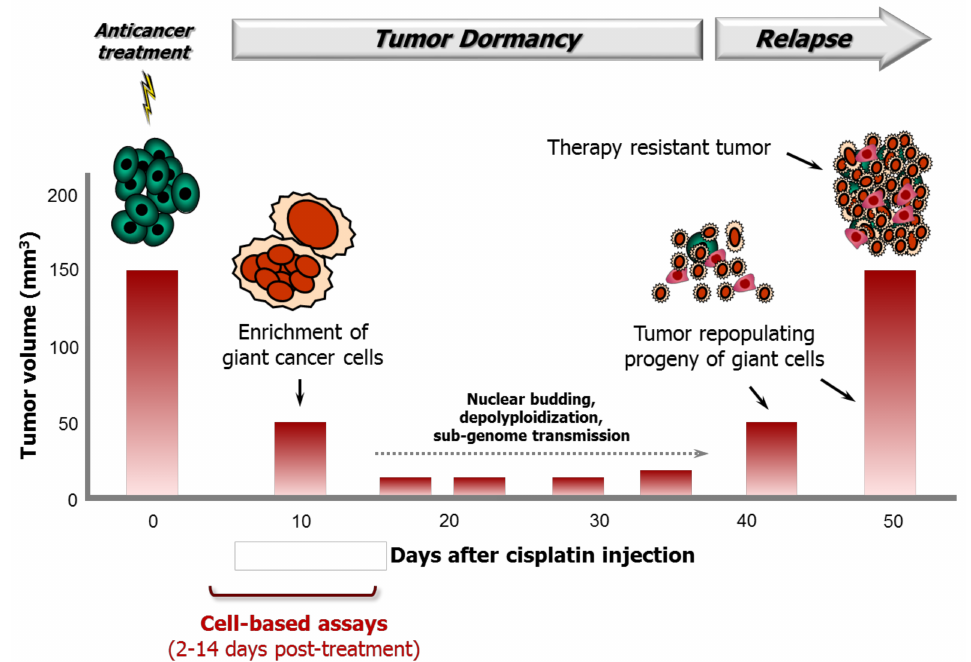
Figure 7. Cartoon illustrating the role of giant cancer cells in tumor response to cisplatin treatment in a syngeneic rat colon carcinoma model reported by Puig et al. [7]. Although cisplatin treatment results in initial tumor shrinkage and a dormant state up to ~35 days post-treatment, it also triggers the creation of polyploid/multinucleated giant cells that give rise to therapy resistant progeny that repopulate the